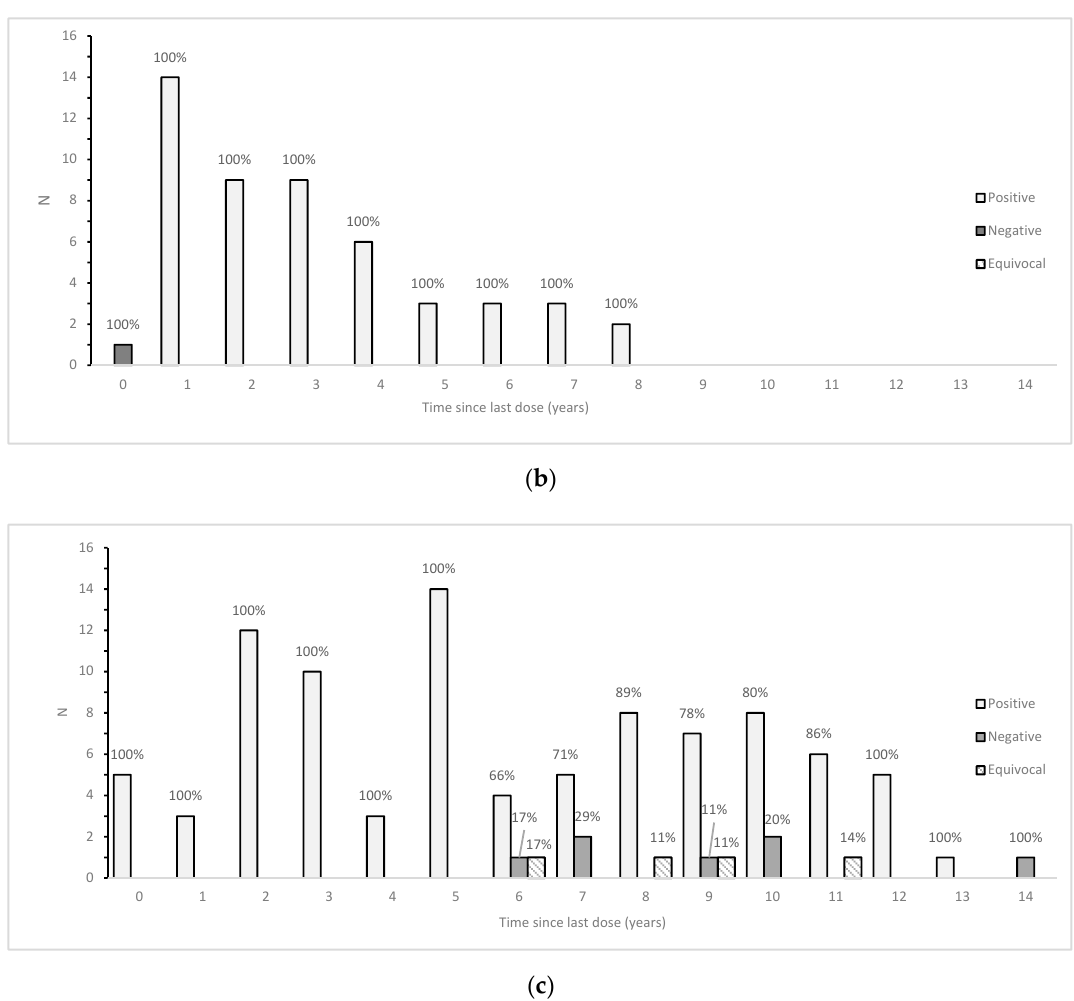
Figure 4. Seroprevalence in relation to time since last dose received. Total doses ( a ), one dose ( b ), two or three doses ( c ). Percentages are shown above each histogram. Logistic regression analysis was performed in the vaccinated population considering the serological status as the outcome (dependent variable) and the time elapsed since the last dose of vaccine as the independent variable. Time elapsed since last dose resulted in being associated with the seroprevalence status (OR 1.28; 95% CI: 1.08–1.55; p < 0.01).